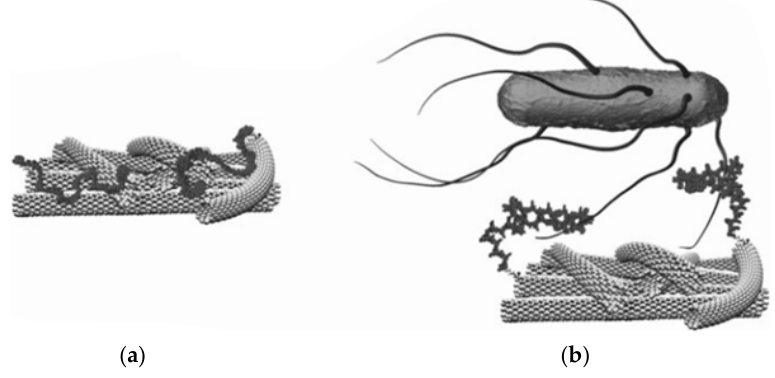
Figure 1. ( a ) Possible conformations of the aptamers that are self-assembled on carbon nanotubes; ( b